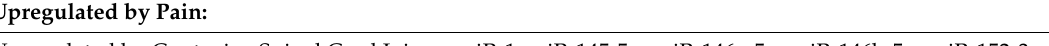
Table 4. List of 84 miRNA used in this